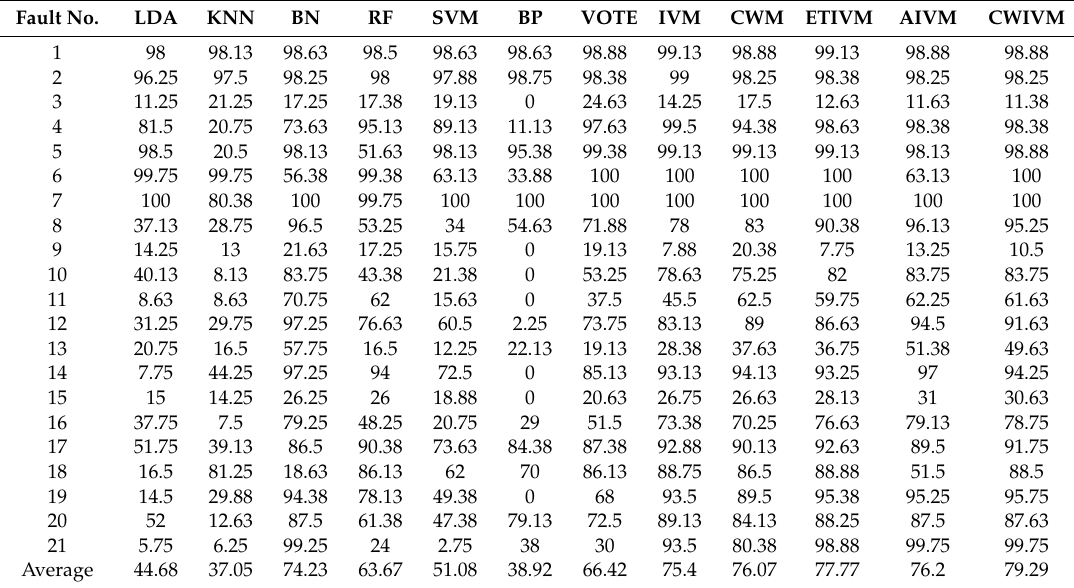
Table 4. Fault classification accuracy of various classifiers